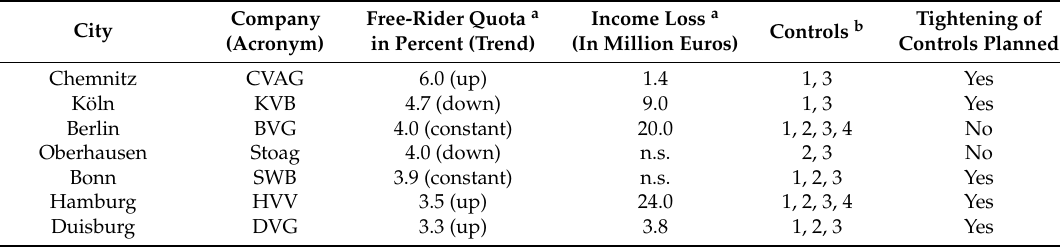
Table 1. Trends in local public transport companies in